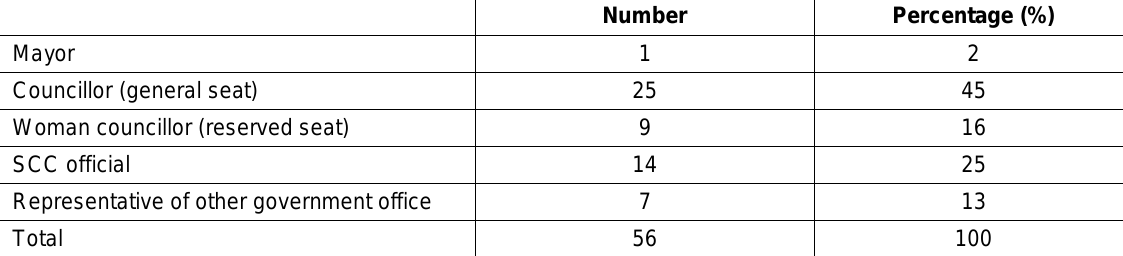
Table 1: Roles of respondents (representatives and